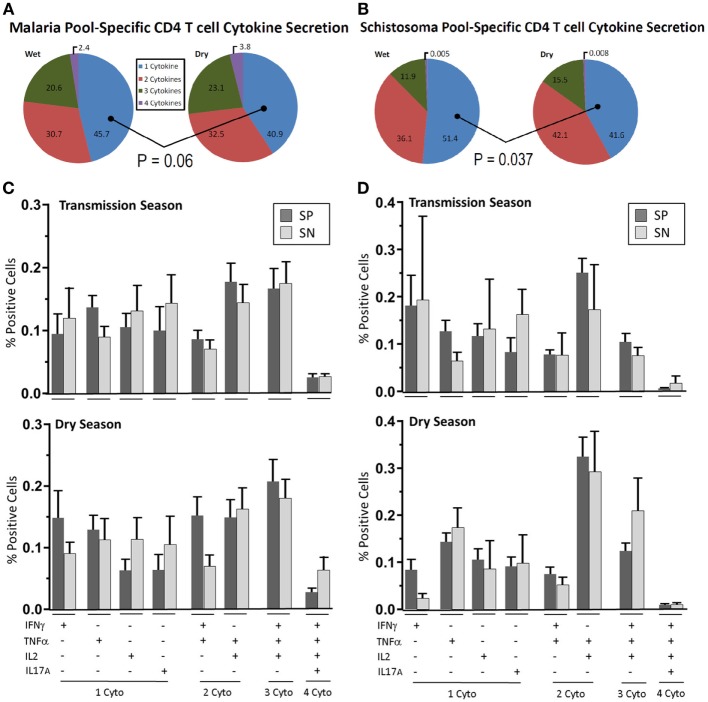
Parasite-specific multifunctional cytokine expression over time. Depicted are pie-charts (A,B) showing the multifunctional nature, expressed as geometric mean of singlet, doublet, triplet, and quadruplet cytokine (IFN-γ, TNF-α, IL2, and IL-17A) combinations secreted from CD4+ T cells after peripheral blood mononuclear cells (PBMC) stimulation with either (A) malaria antigen pool (apical membrane antigen 1 and merozoite surface protein 1) or (B) schistosoma antigen pool (soluble egg antigen and soluble worm antigen protein). PBMC were acquired from schistosoma-negative (SN) or -positive (SP) Malian children aged 4–14 years at the time of acute malaria during the transmission season and again, 6 months later, during the dry season. The most prevalent cytokine combinations expressed to malaria antigen stimulation (C) or schistosoma antigen stimulation (D) are depicted for each group (SP—dark bar, SN—light bar) during the transmission season and dry season. Results are depicted as the mean percentage of positive cells with SE. The dot plot depiction of individual cytokine net percentage of response is depicted in Figure S3 in Supplementary Material.